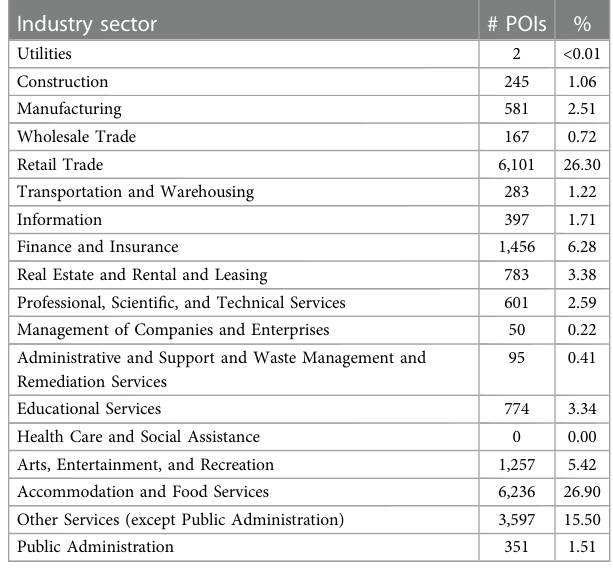
TABLE 1 Industry distribution of the safe graph